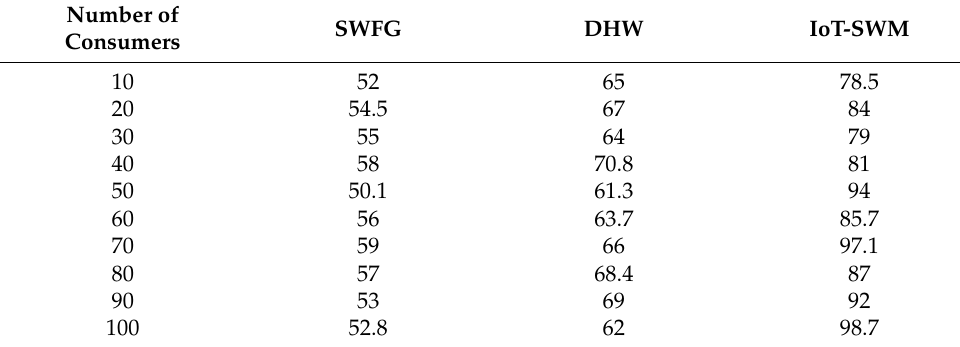
Table 1. Analyses of stormwater quality.